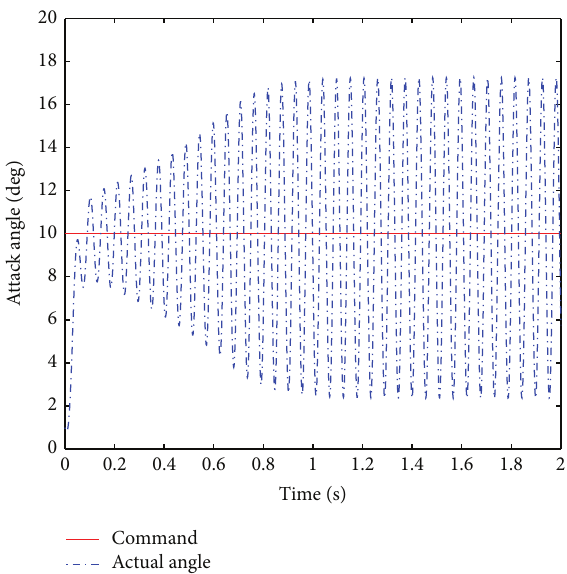
Figure 4: Tracking curve of attack angle under the conventional control